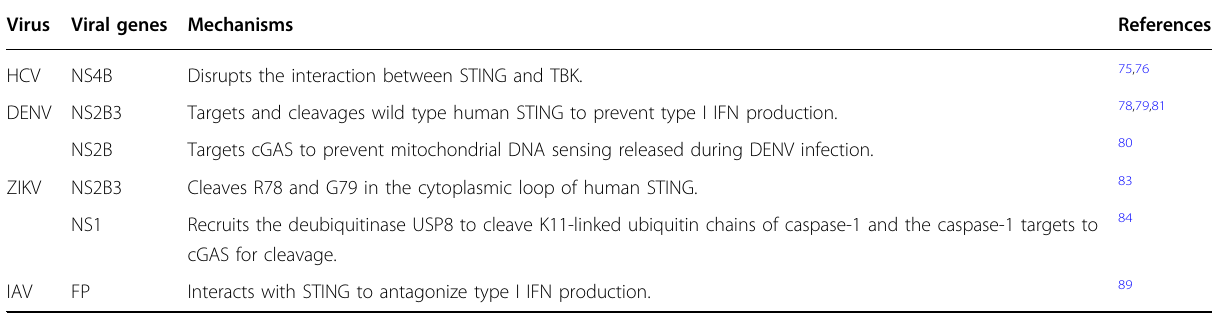
Table 2 Blocking STING-dependent innate immunity by RNA virus infection Virus Viral genes